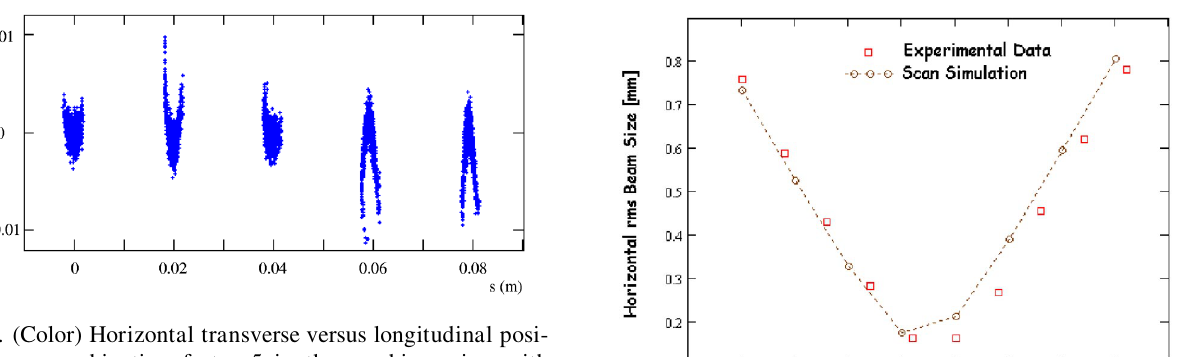
FIG. 9. (Color) Horizontal transverse versus longitudinal posi- tion for a combination factor 5 in the combiner ring with realistic energy spread for the injected bunches.